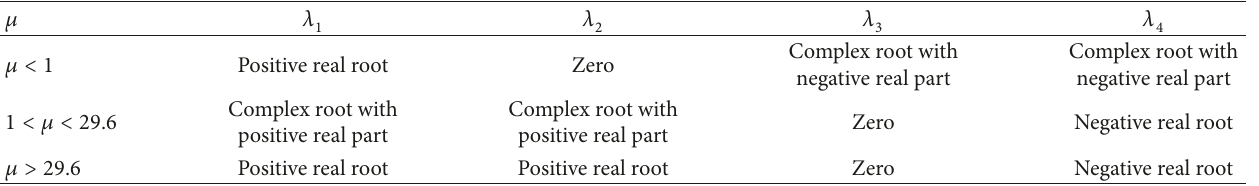
Figure 3: Eigenvalues distributions of three-line equilibrium points with the variation of 𝜇 , where the system parameters are set as a = 0.7 and b = 10. (a) Line equilibrium point S 0 . (b) Line equilibrium points S ± . Table 1: Eigenvalues of line equilibrium point 𝑆 0 in different initial condition regions of 𝜇